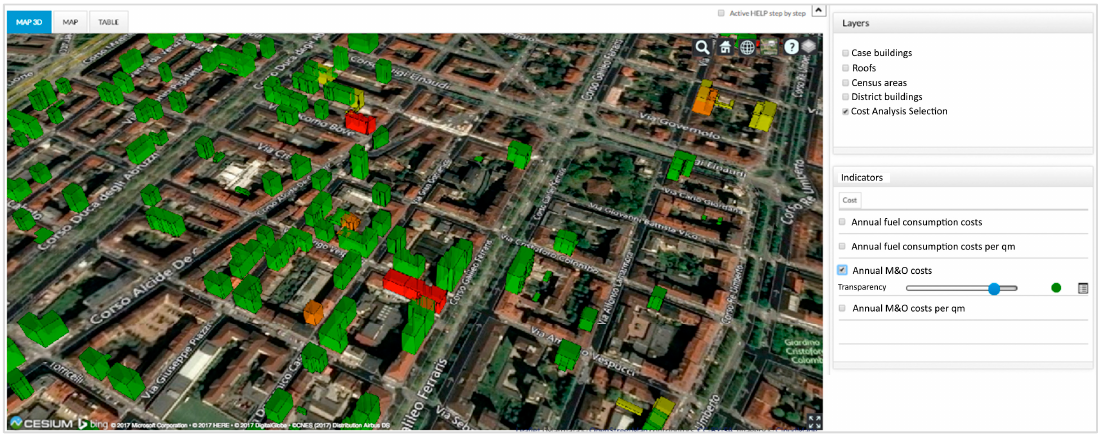
Figure 3. Visualization of the annual O and M costs for each considered building.